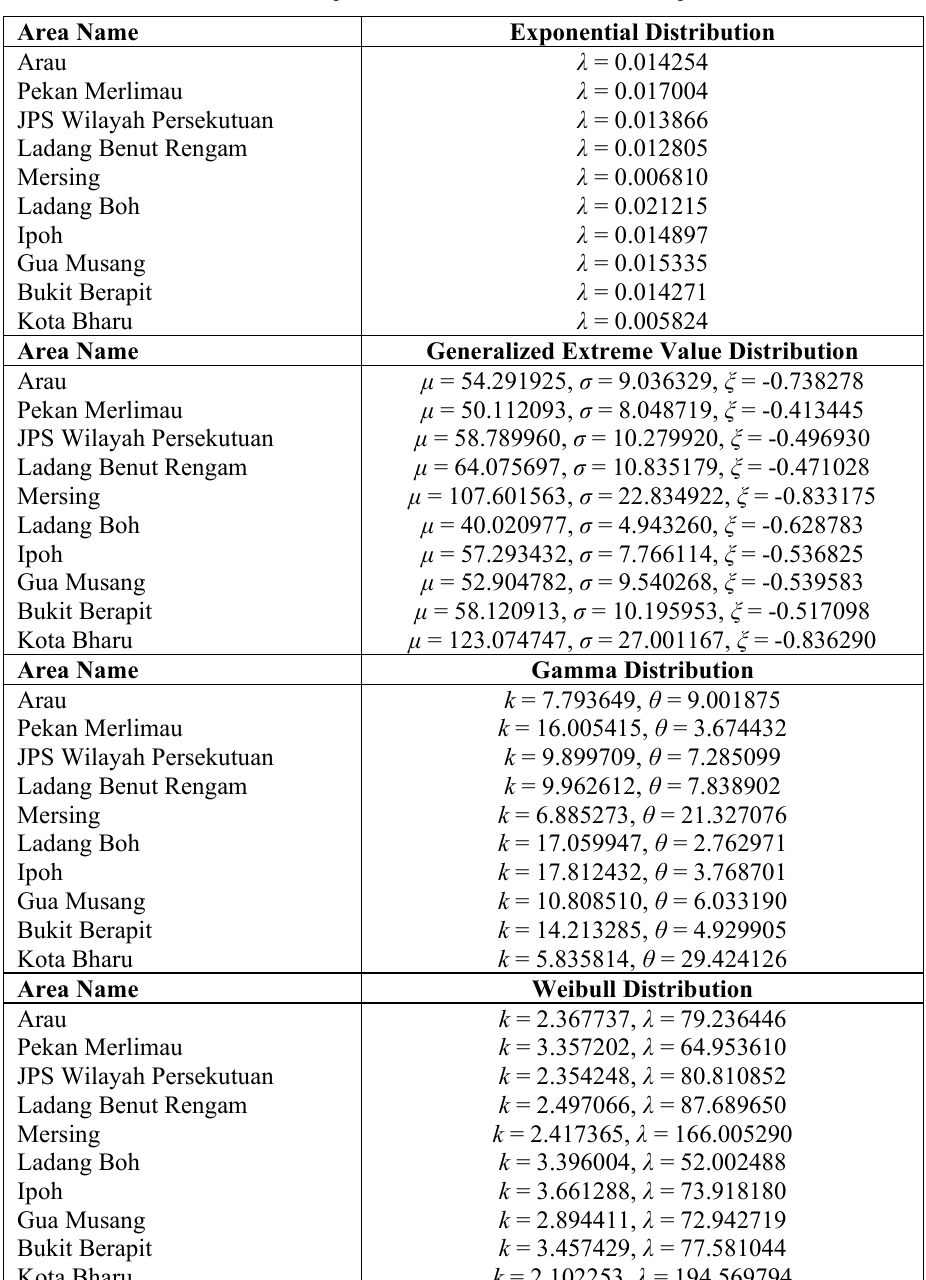
Table 3. Estimated parameters for threshold value of 95 th